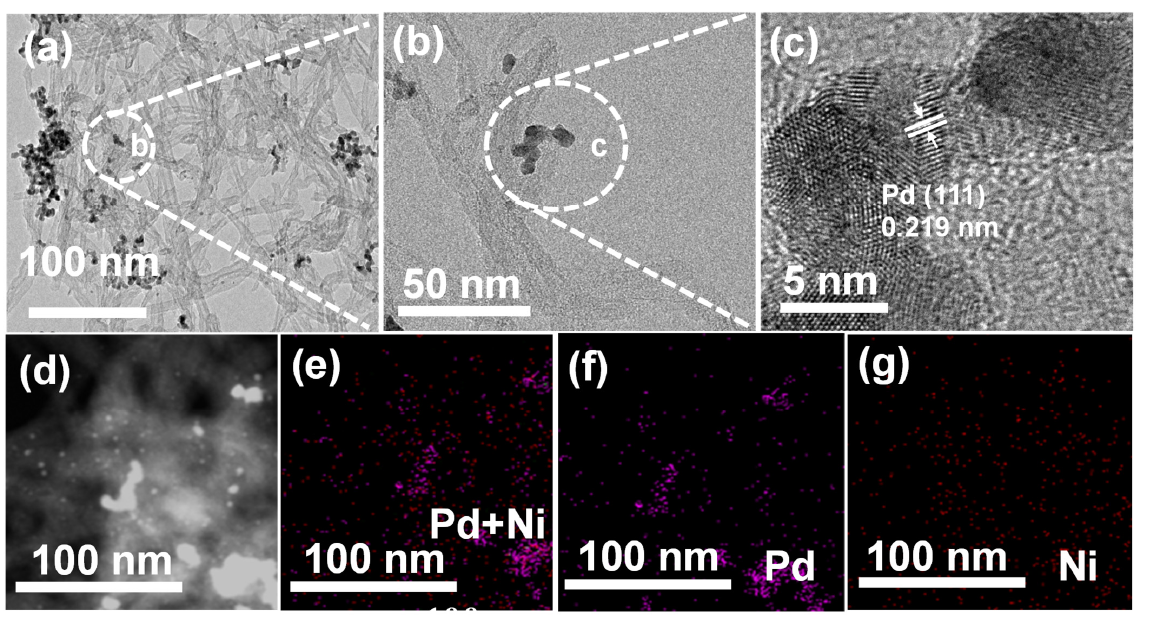
Figure 2. ( a , b ) TEM and ( c ) HRTEM images; ( d – g ) HAADF-STEM elements mapping, the corre- sponding elements Pd and Ni of Pd 2 Ni 1 /CNTs.